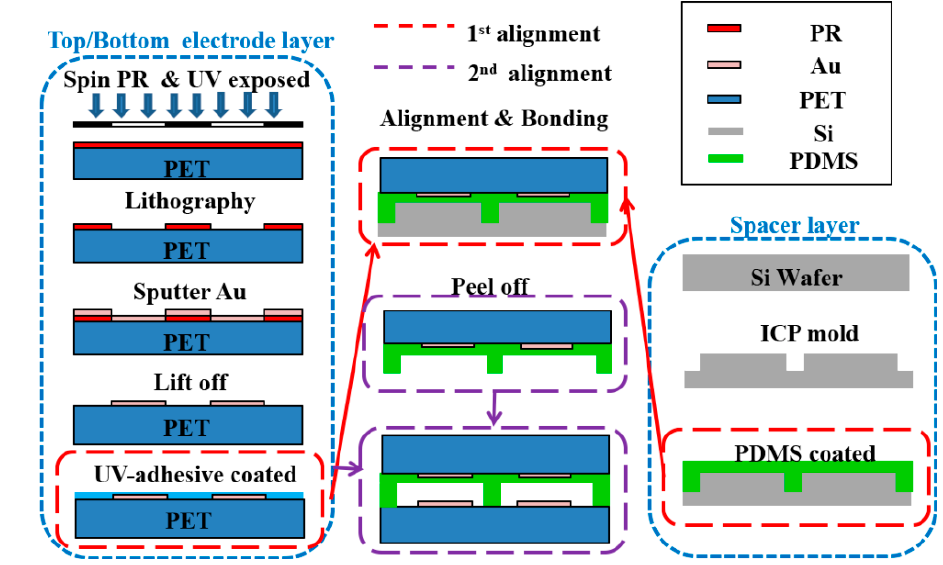
Figure 2. Schematic of fabrication process in the capacitive tactile